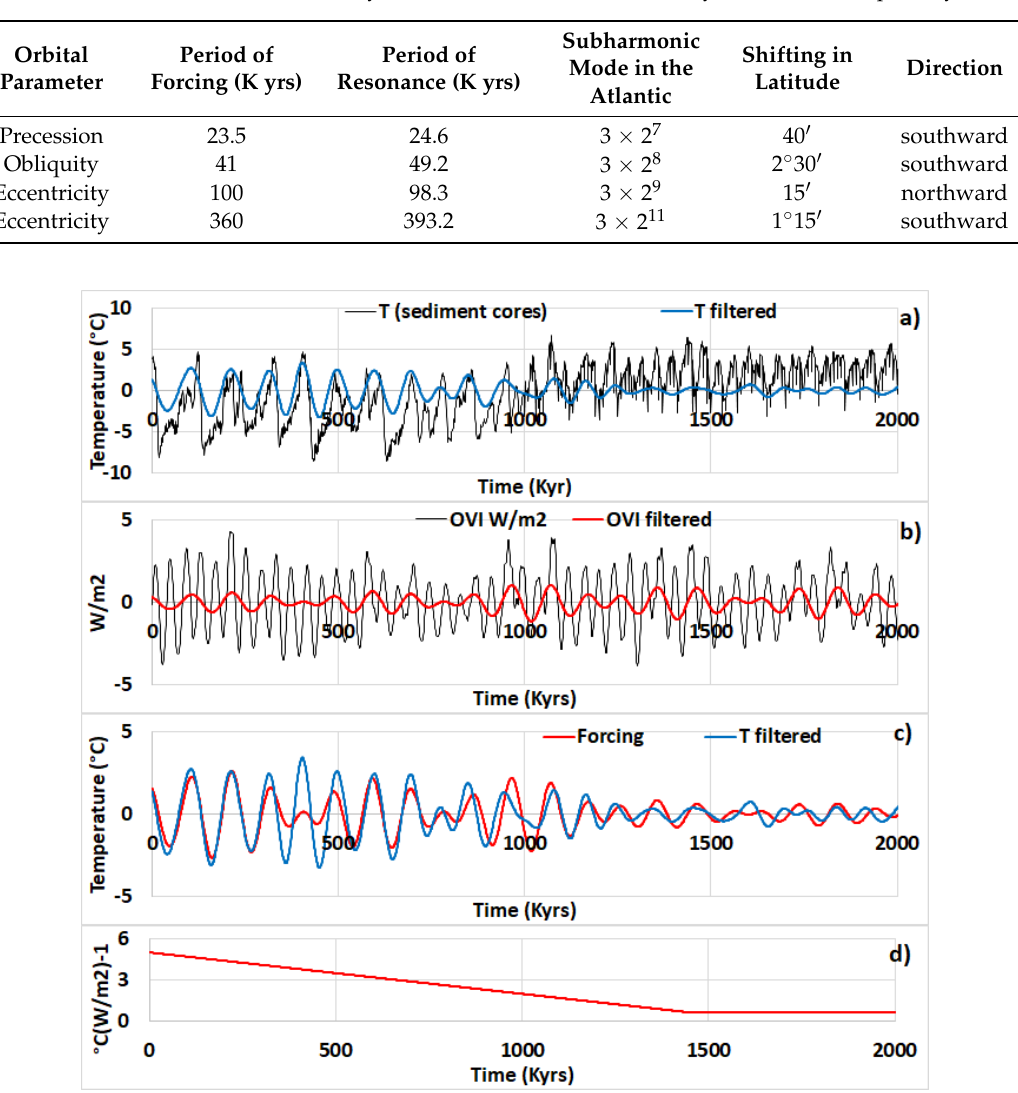
Figure 9. Impact of the eccentricity on the Gyral Rossby Waves (GRWs) into the band 73.7 – 147.4 K yrs; ( a ) Global mean temperature estimated from foraminifera in sediment cores; ( b ) Orbital Variations of Insolation (OVI); ( c ) Comparison of the OVI multiplied by the forcing efficiency and the global mean temperature; ( d ) the forcing efficiency.